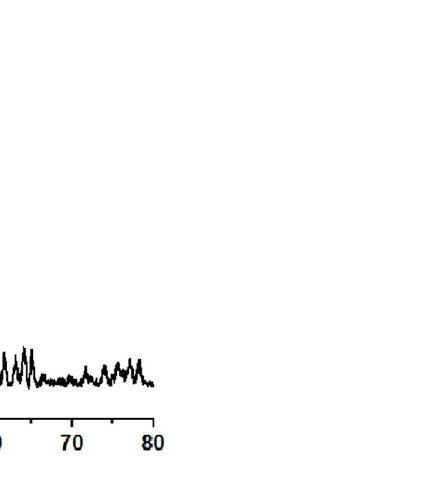
Fig 17. XRD pattern at optimum conditions (time = 10 h, temperature: = 130˚C, pH = 10).